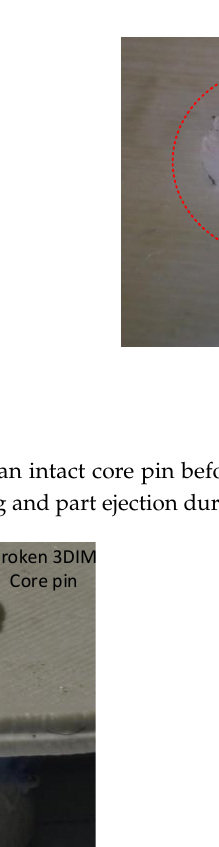
Figure 18. ( a ) 3DIM insert showing part missing from the tool that was broken during ejection; ( b ) Broken part of 3DIM tool material stuck to the moulded part. (White material is the 3DIM tool and grey material is the part).